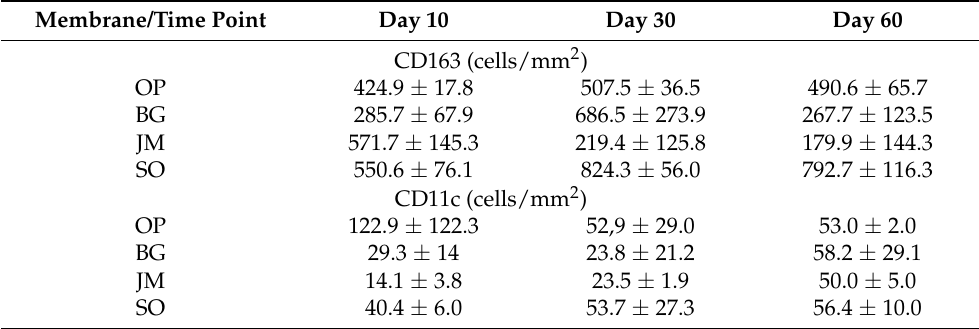
Table 1. Histomorphometrical results of the immune response within the implantation bed of the analyzed barrier membranes (Ossix ® Plus (OP), Bio-gide ® (BG), Jason ® membrane (JM), and sham operation